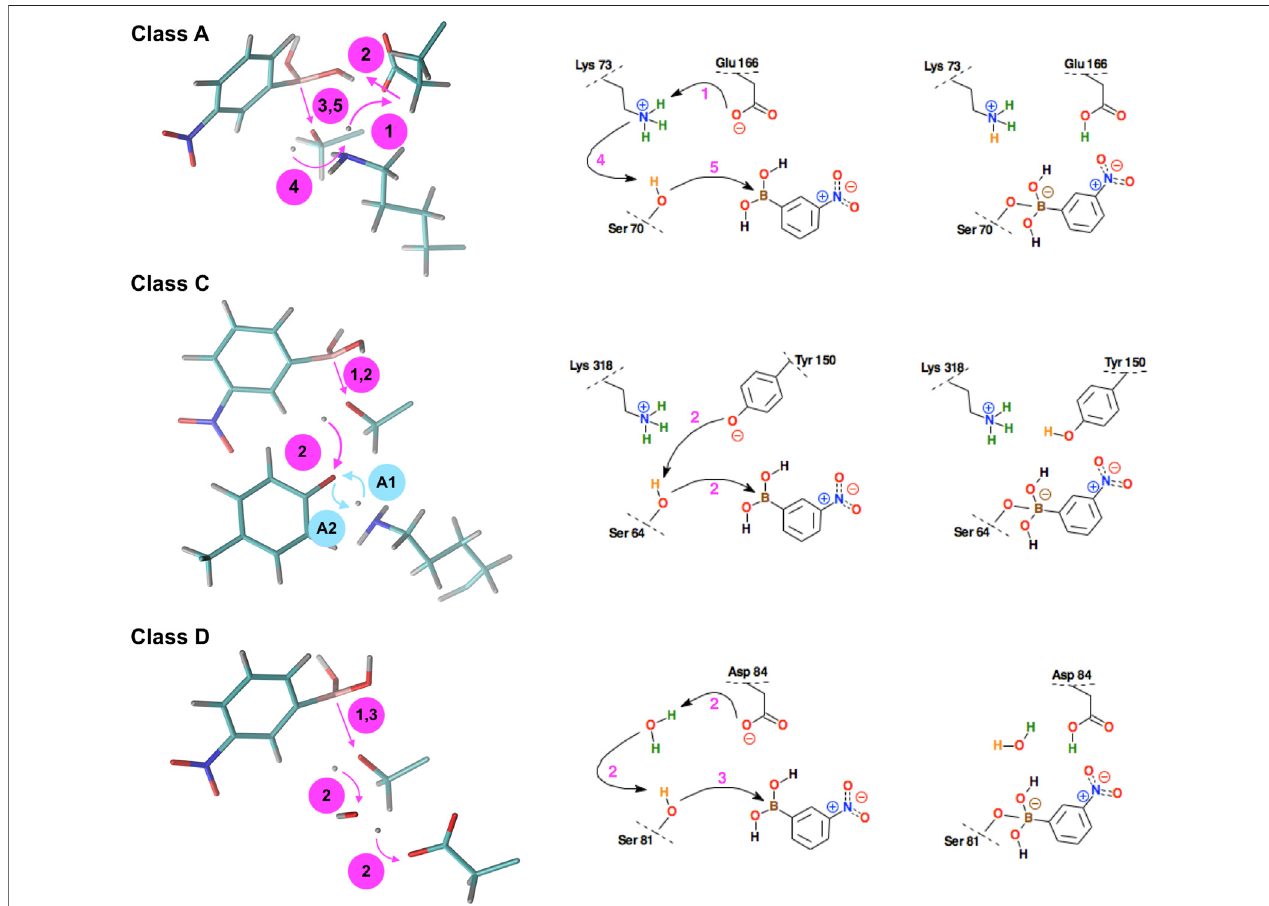
FIGURE 6 | Schematic representation of the successive steps in the formation of the chemical bond between the boron atom of the 3-NPBA inhibitor and the hydroxyl groups of serine β -lactamases. The active site residues belong to KPC-2 β -lactamase (class A), GC1 β -lactamase (class C), and the K84D mutant of OXA-24 β -lactamase (class D). On the left - curved arrows indicate the proton transfer processes, straight arrows indicate distance reduction. In class C, steps #A1 and #A2 (denoted by blue annotations) were observed, however, they are mutually reversible, leading fi nally to the structure as in step #1. On the right, conventional simpli fi ed diagrams showing reaction steps - the arrows symbolically indicate the electron transfer processes. Description of the time-periods related to the presented steps is given in Table 1 .